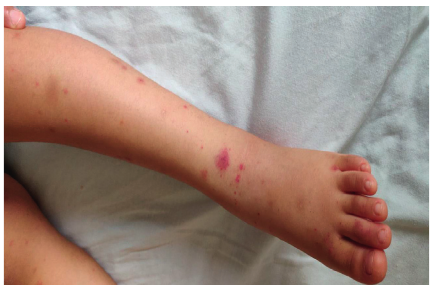
Figure 3: The characteristic leg rash of case